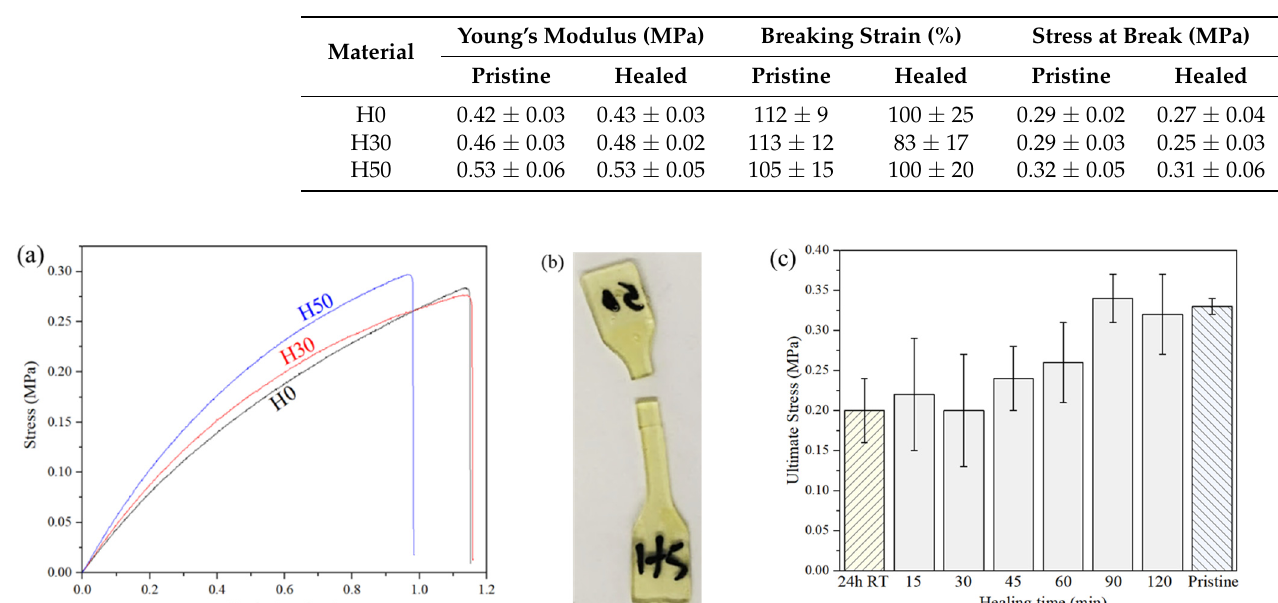
Table 3. Tensile tests result for H0, H30 and H50 after 2 h at 75 ◦ C, without and with prior complete separation.